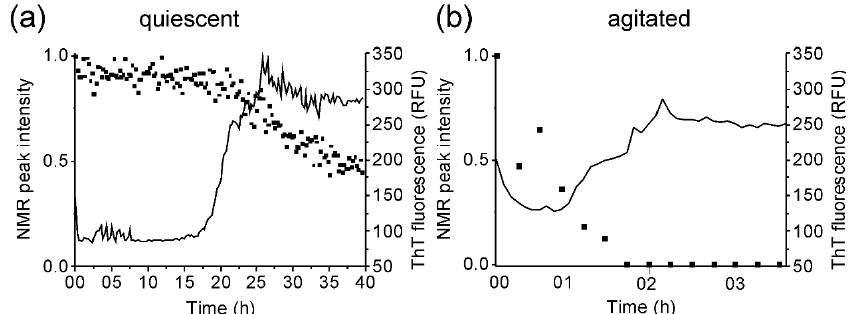
Figure 1. Fibrillation of medin. Thioflavin (ThT) fluorescence (solid line) for 20 µM medin incubated in 20 mM NaPhos, 20 mM NaCl, pH 7.4 at 37 °C under ( a ) quiescent and ( b ) agitated conditions. Results are shown as the mean of three replicates. NMR peak intensity (symbols) normalised to starting intensity.